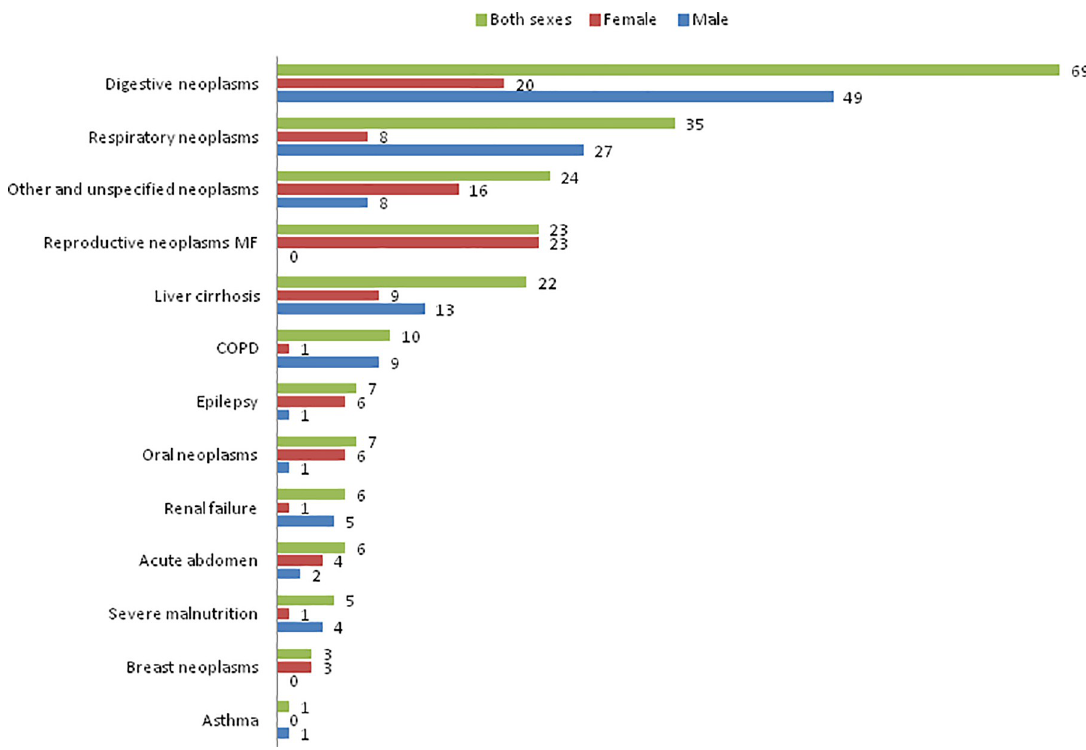
Fig 3. Numbers of deaths from endemic non-communicable diseases, PNGIMR’s CHESS,